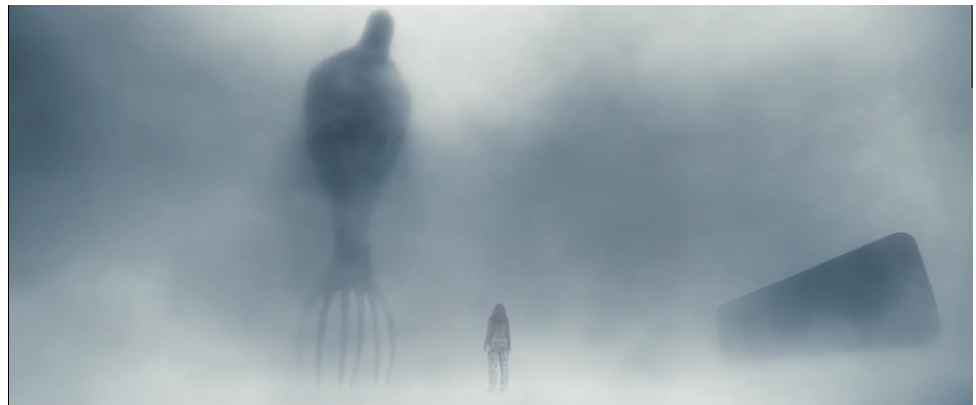
Figure 7: Arrival . Louise enters the inner